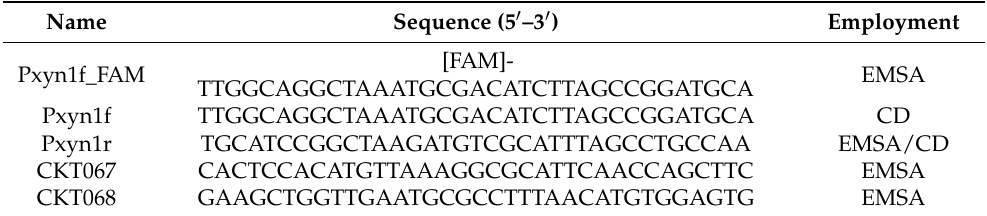
Table 1. Oligonucleotides used in the